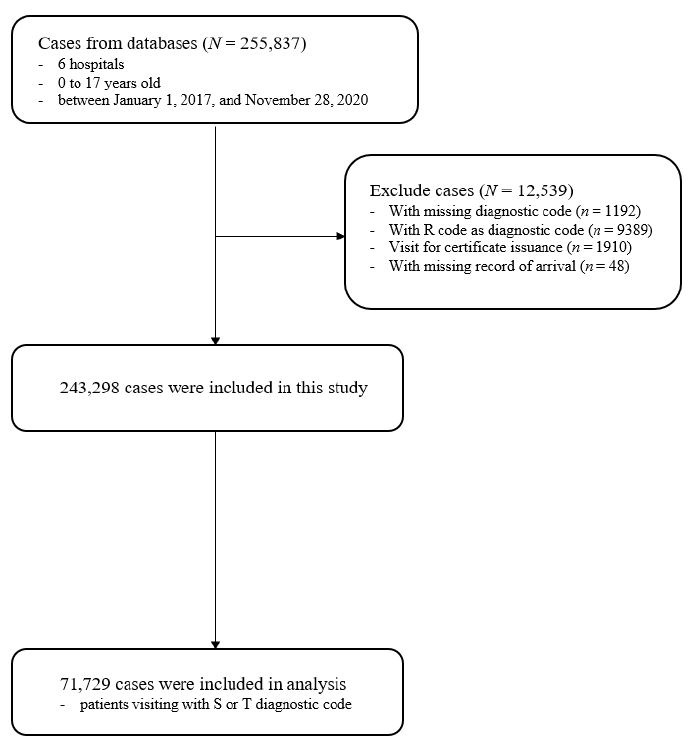
Figure 1. Flow chart of the study population.